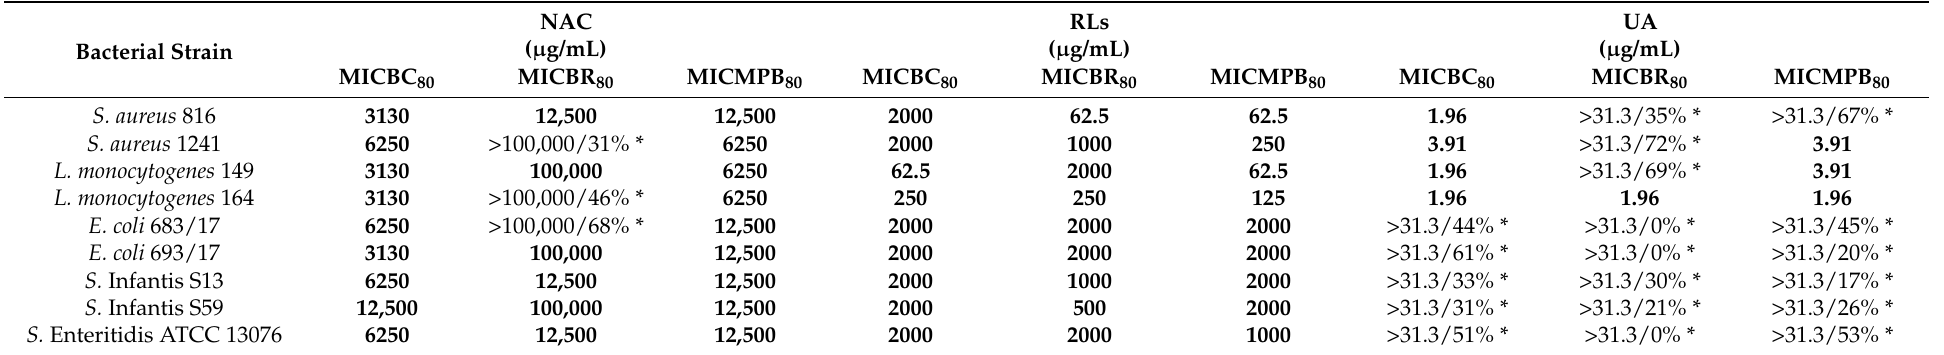
Table 2. Minimal inhibitory concentrations of N -Acetyl- L -cysteine (NAC), rhamnolipids (RLs), and usnic acid (UA) inhibiting further growth of biofilm cells, its metabolic activity, and resulting in biofilm reduction. The significance of the results was verified by t -test ( p = 0.05).